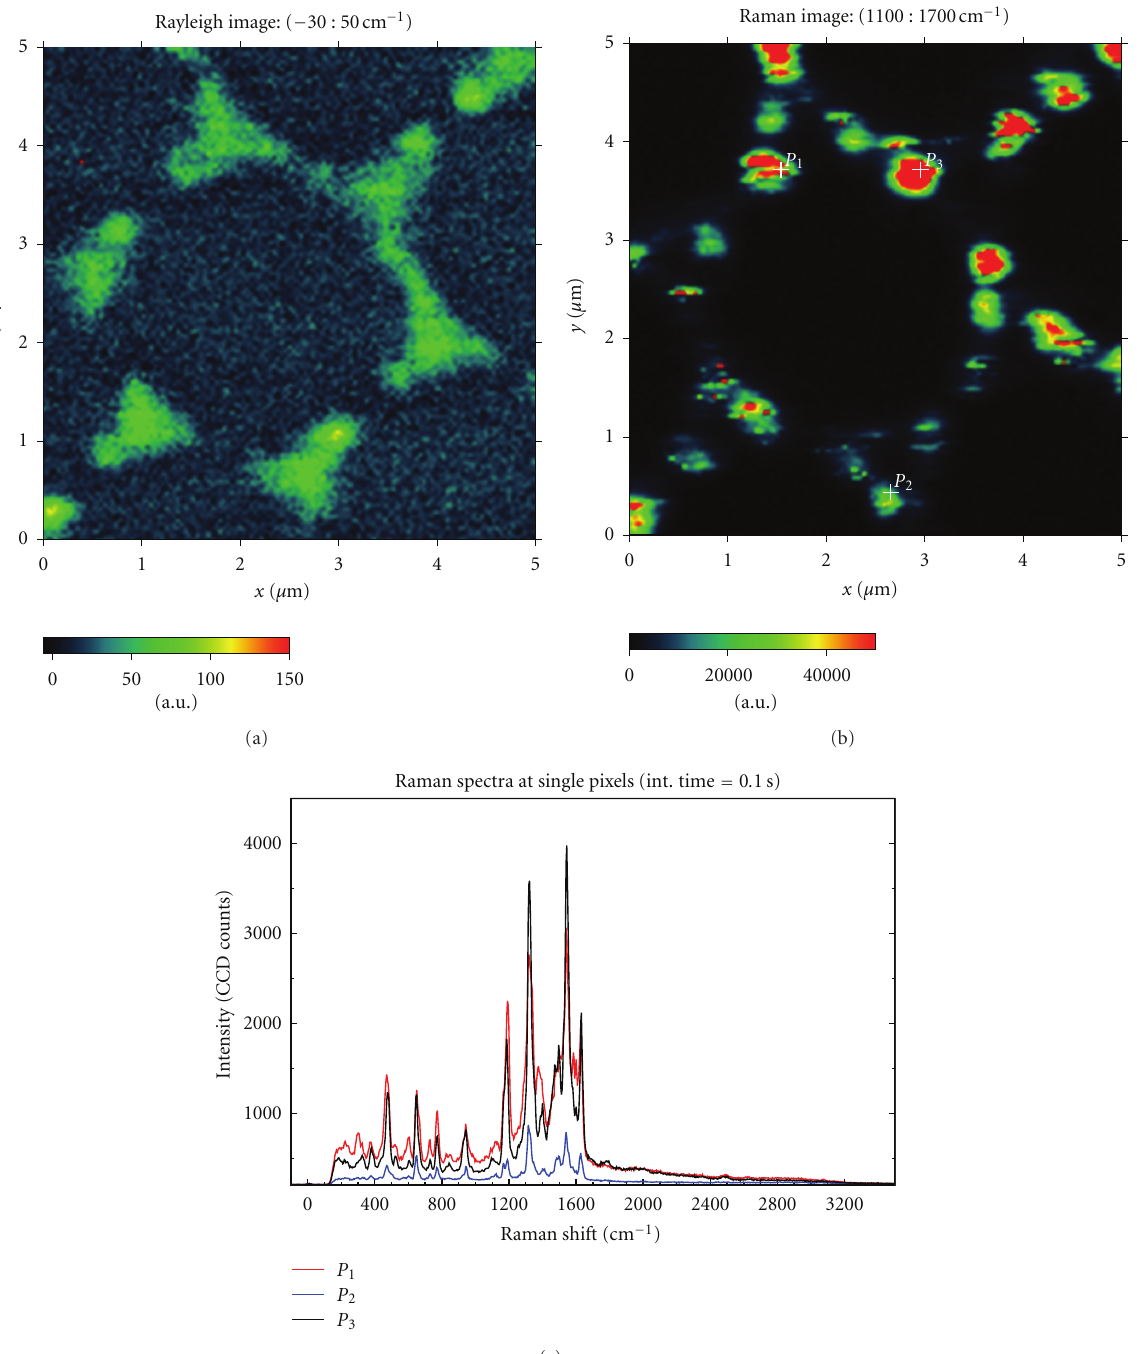
Figure 6: SERS of fluorescein molecules on silver patterns of 3 μ m diameter and 50 nm thickness. λ = 532nm. P exc = 12 μ W. Three spectra below were extracted from the pixels